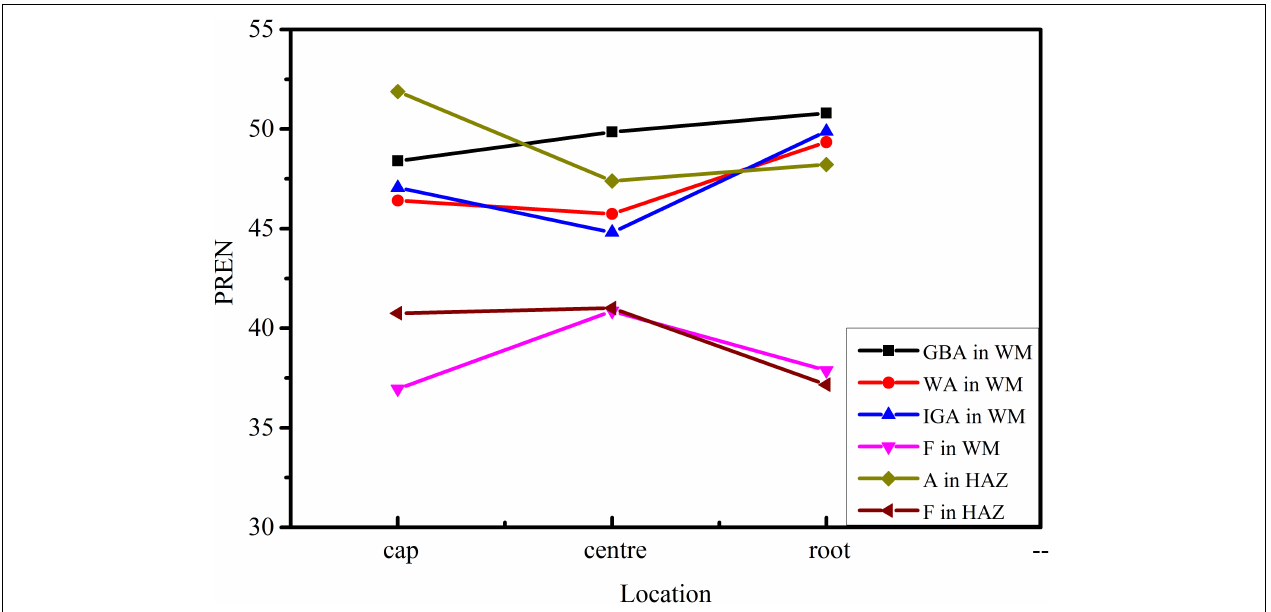
FIGURE 6 | The PREN values of austenite and ferrite in the weld